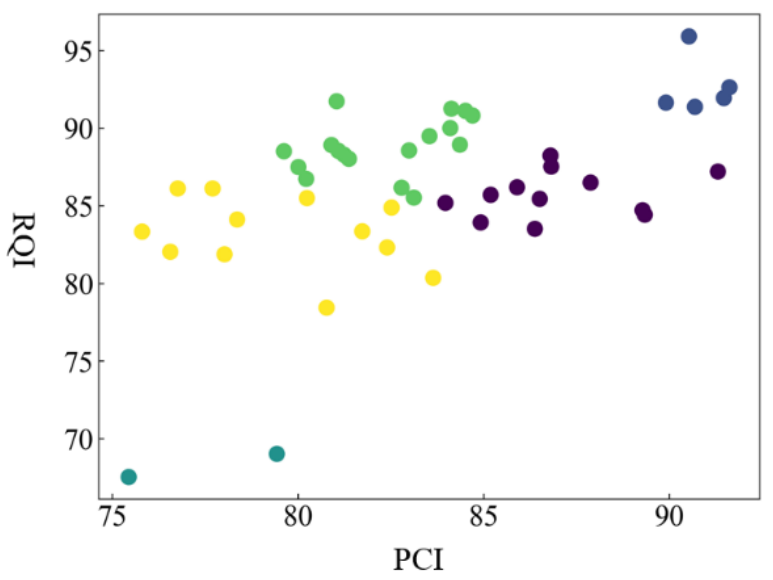
Figure 8. Five groups of cluster diagrams obtained by using K-means algorithm based on PCI and RQI data.